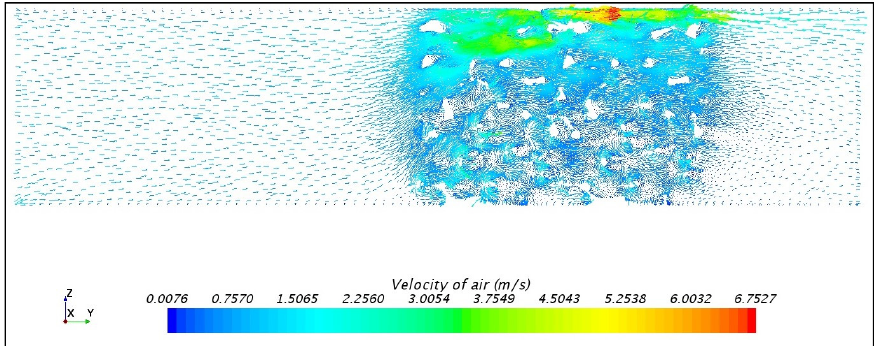
Figure 14. Distribution of air velocity in the pipe with foam packing.